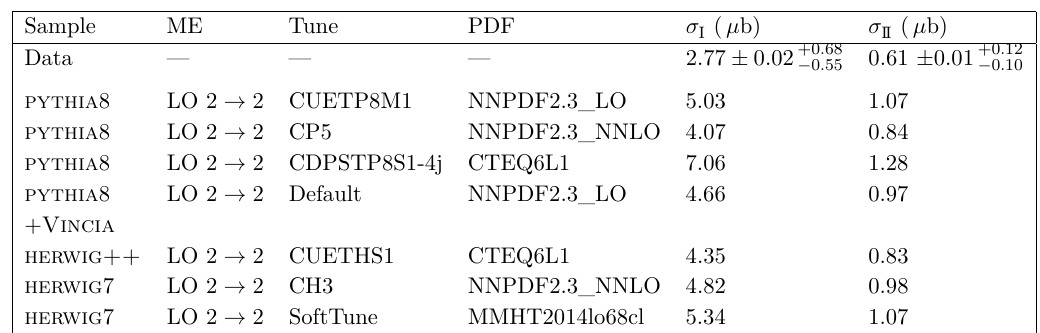
Table 3 . Cross sections obtained from data and from the pythia 8, herwig++ , and herwig 7 models in Region I and Region II of the phase space, where ME stands for matrix